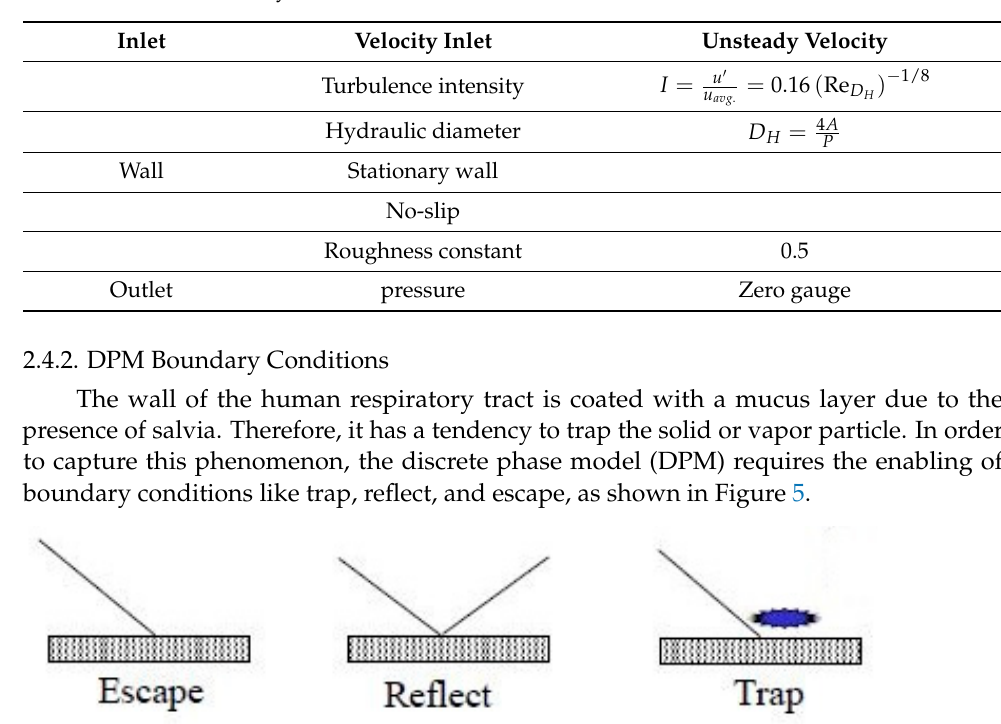
Figure 4. Inhalation and exhalation flow rate during smoking.; [Pattern taken from British American Tobacco (www.bat.com).]. Other airway boundary conditions are shown in Table 2. Other airway boundary conditions are shown in Table 2. Table 2. Airflow boundary conditions. Table 2. Airflow boundary conditions.